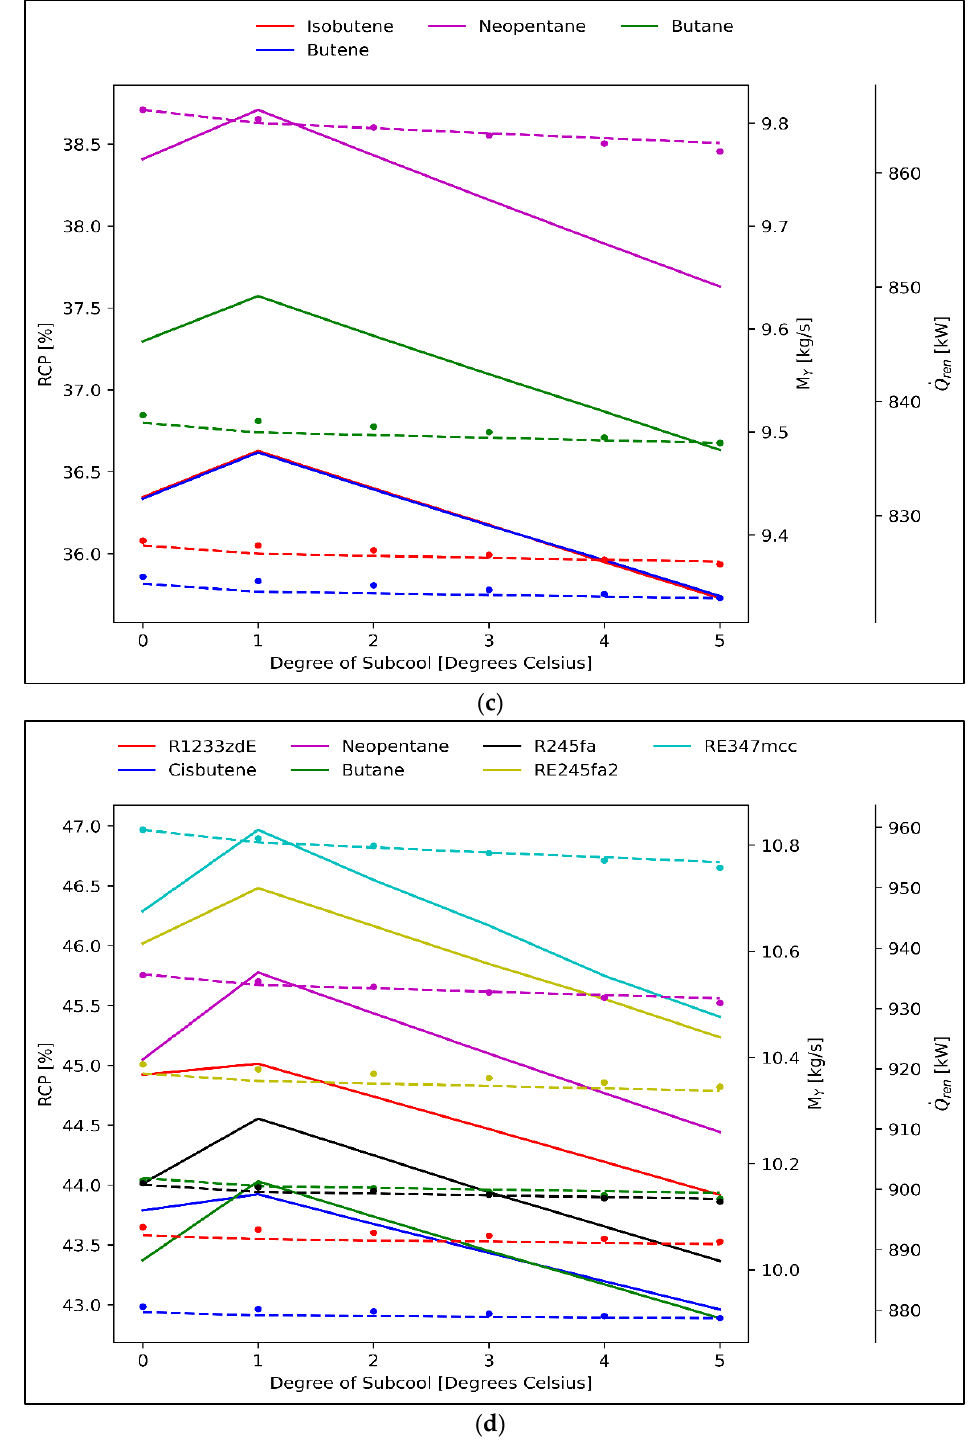
Figure 7. Degree of condenser subcooling vs. reduction in power consumption and renewable energy input ( a ) at 90 °C; ( b ) at 100 °C; ( c ) at 110 °C; and ( d ) at 120 °C. Solid Lines: RCP , Dots: 𝑄̇ 𝑟𝑒𝑛 , Dashed Lines: M Y .